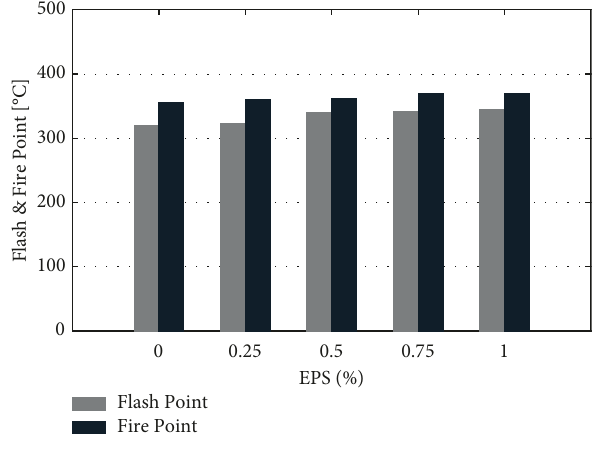
Figure 5: Variation of penetration value.